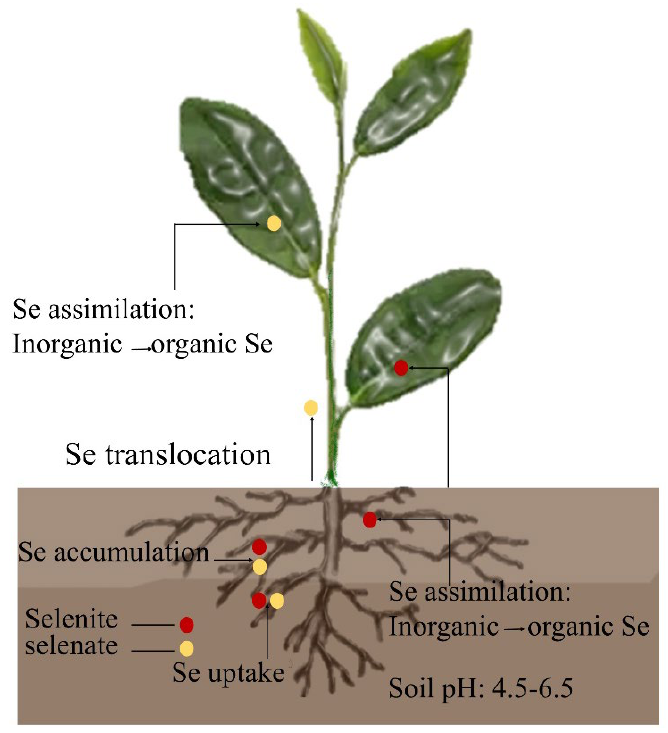
Figure 1. Uptake and transport of selenate and selenite by tea plants.